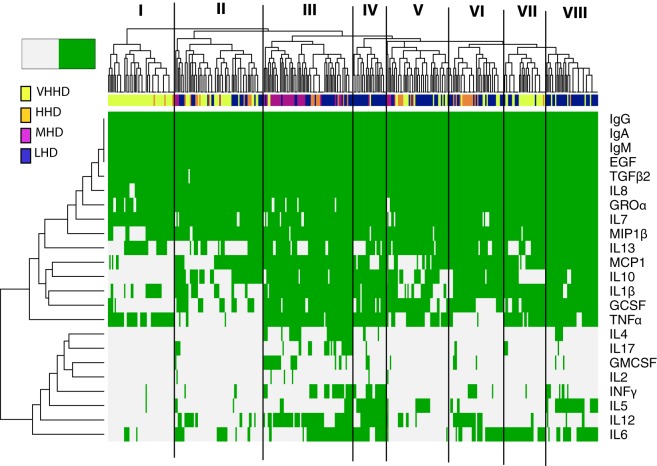
Heatmap representing the detection frequency of the immunoglobulins, cytokines, growth factors, and chemokines quantified in human milk (green: present; grey: absent). Each row represents the detection frequency for an individual specific immune factor as indicated on the y-axis, and each column represents an individual sample/subject. Hierarchical clustering of the 365 samples analyzed is shown in the upper dendrogram. Color-coded bar accompanying the dendrogram represents the level of development of the geographical locations analyzed, according to the human development index [United Nations Development Program; (28)]. LHD, countries with low human development index; MHD, countries with medium human development index; HHD, countries with high human development index; VHHD, countries with very-high human development index.